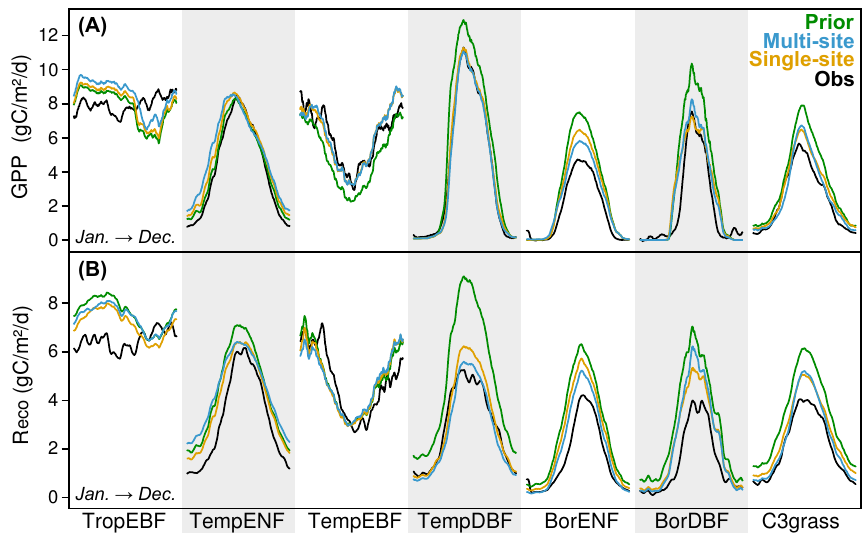
Figure 5. PFT-averaged mean seasonal cycles of (a) the photosynthetic carbon flux and (b) the respiration flux, smoothed with a 15-day moving-average window. The simulations using prior (green), single-site (orange) and multisite (blue) parameterizations are compared to the evaluative observation-derived flux estimates (black).